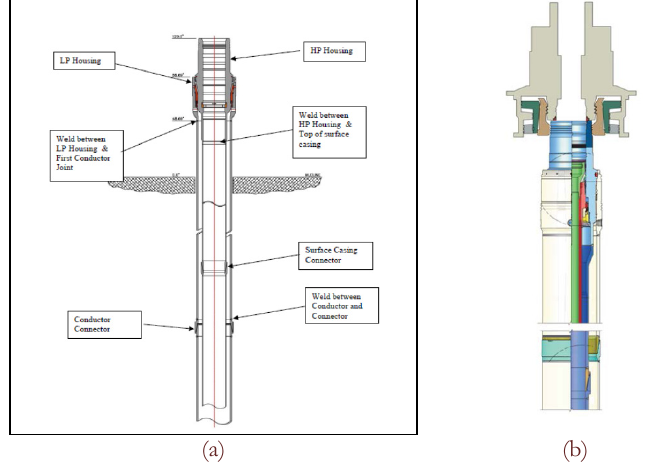
Figure 1: Typical wellhead system: (a) schematic presentation [5]; (b)